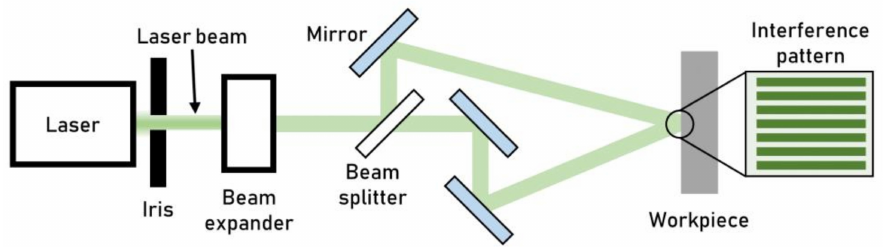
Figure 10. Schematic diagram of the DLIP process